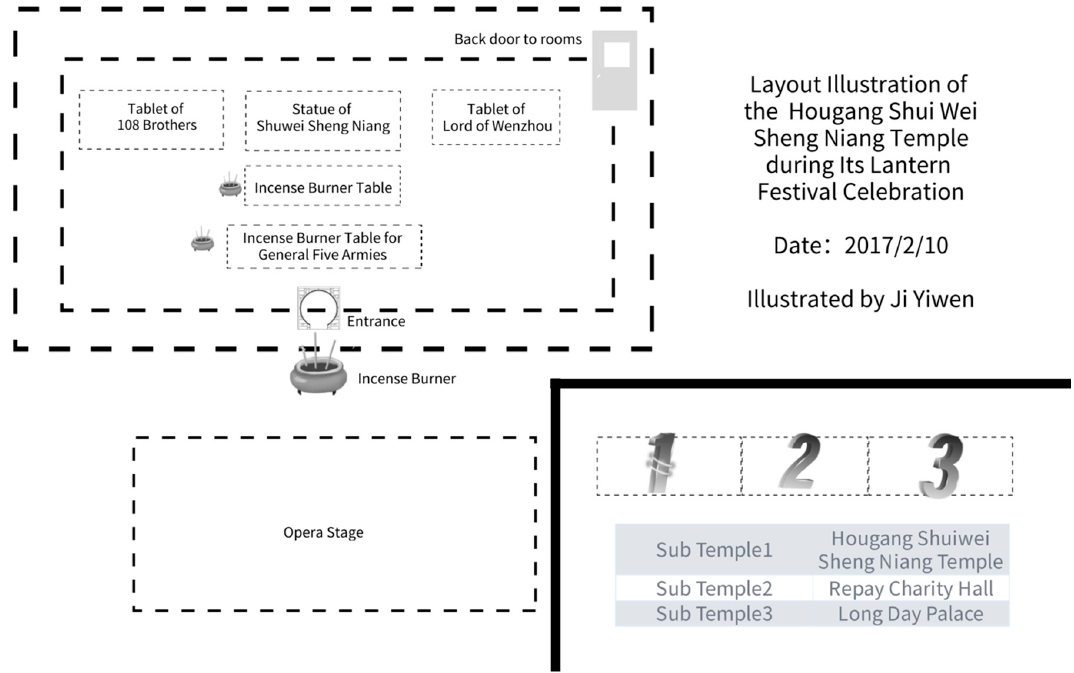
Figure 1. Open area of the courtyard between the temple and the opera stage.